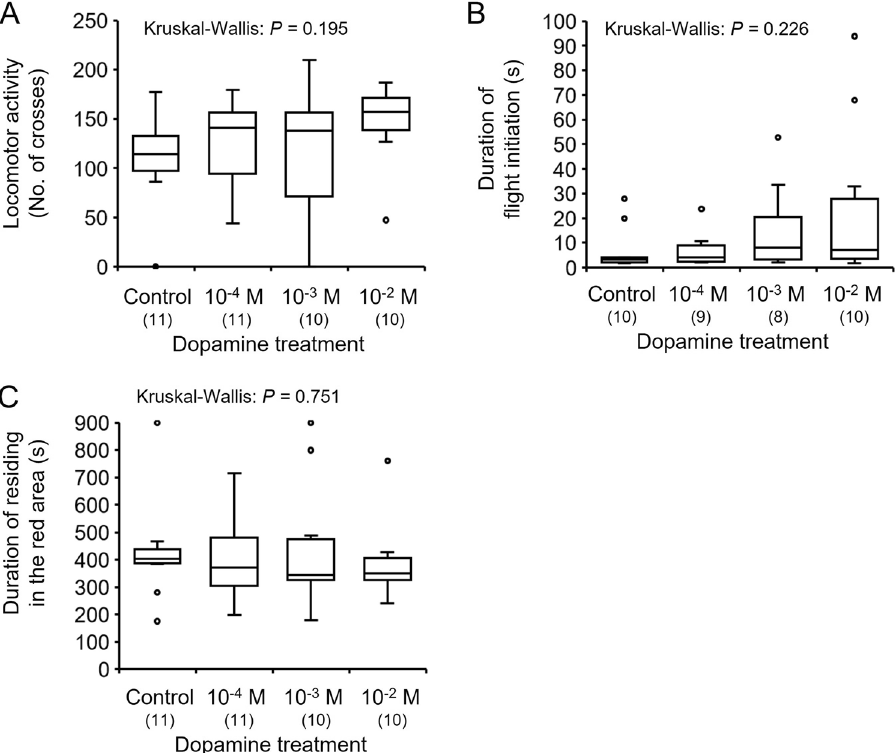
Figure 4. Effects of dopamine injection on behavioral activities of 4-day-old males in the bumble bee: ( A ) spontaneous locomotor activity, ( B ) duration of flight initiation, and ( C ) duration of time residing in the red area as a light preference index. Locomotor activity, duration of initiation, and duration of residing in the red area are indicated by box plots. Sample sizes are shown in